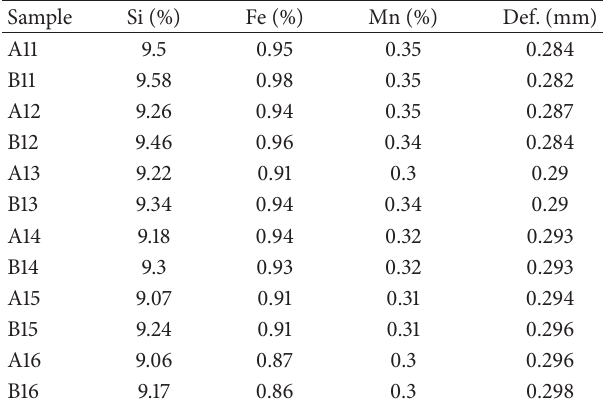
Table 5: Obtained content values of chosen elements (Si/Fe/Mn) of particular samples of the casts and values of residual deformation after content correction of Fe-Mn.